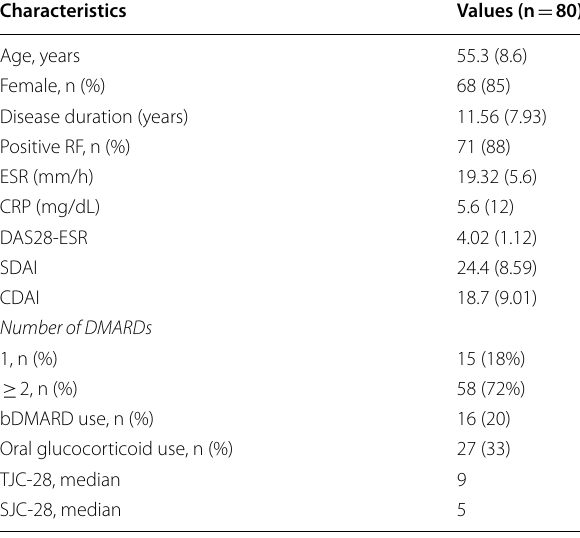
Table 1 Clinical and demographic characteristics for all